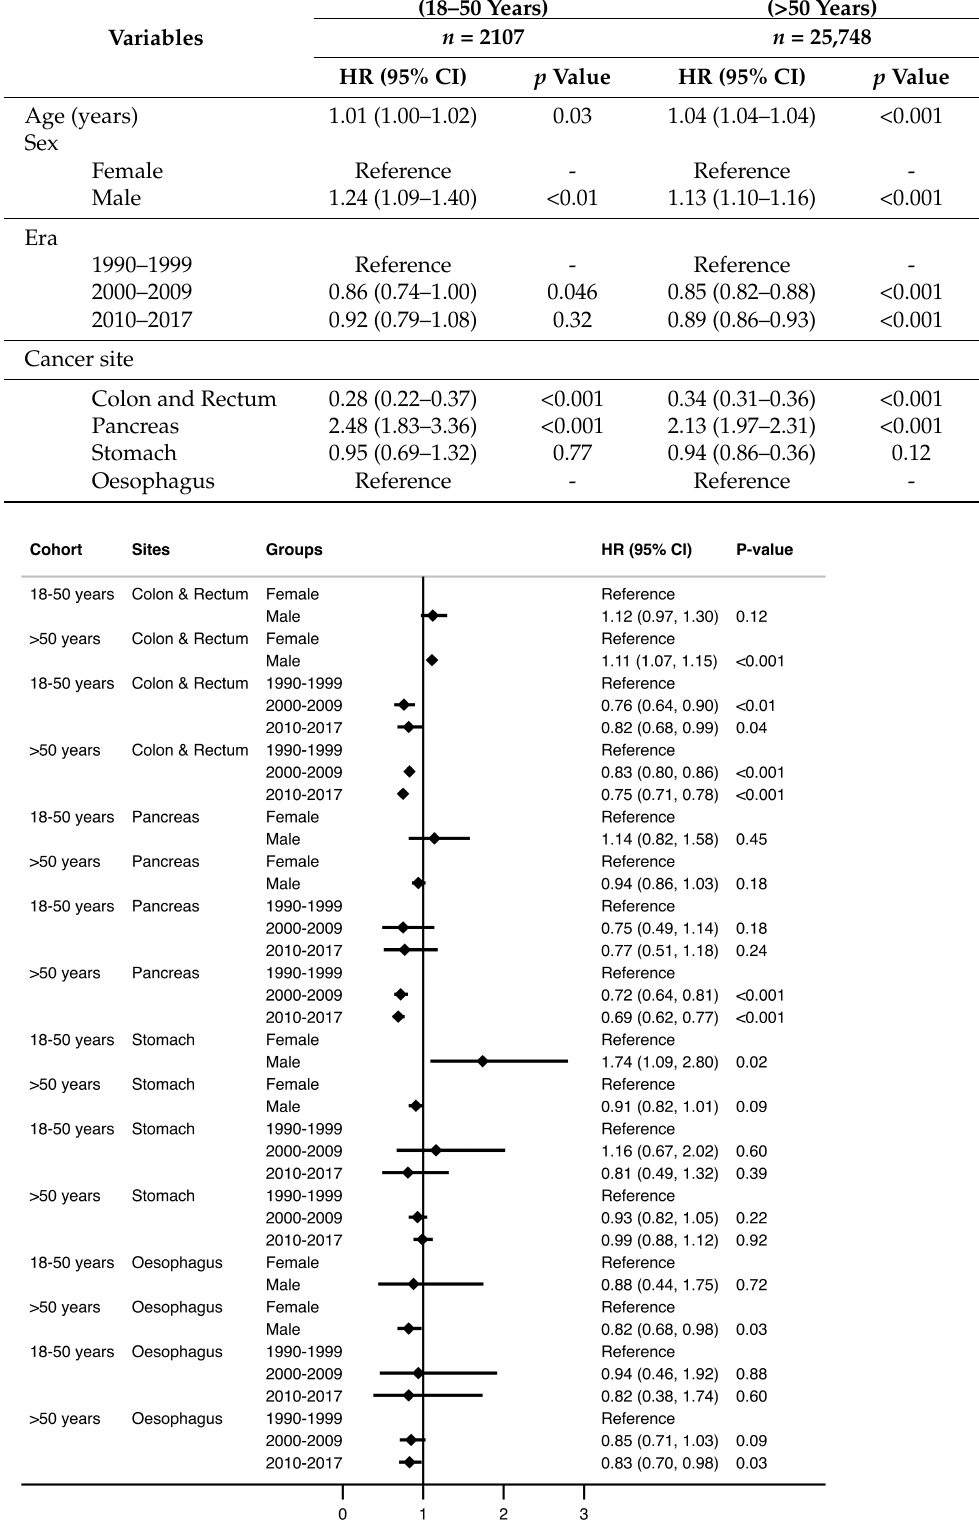
Table 4. Hazard ratios (HR) and 95% CI (Cox proportional hazard model) for age, sex, era, and cancer sites between two age groups ( n = 27,855).